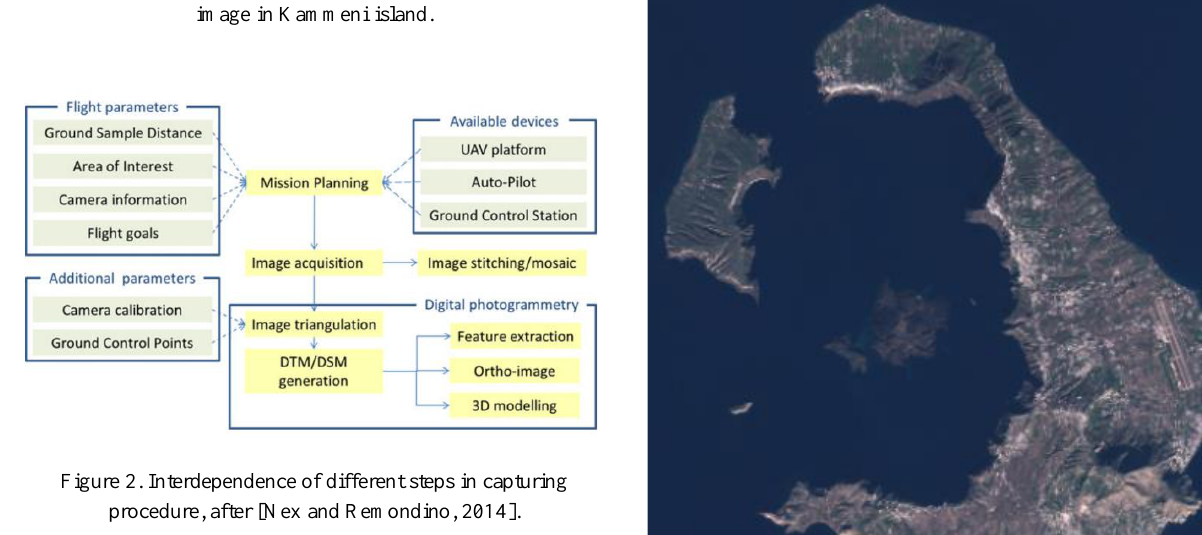
Figure 1. Left-captured image in Oia village, Right- captured image in Kammeni island.